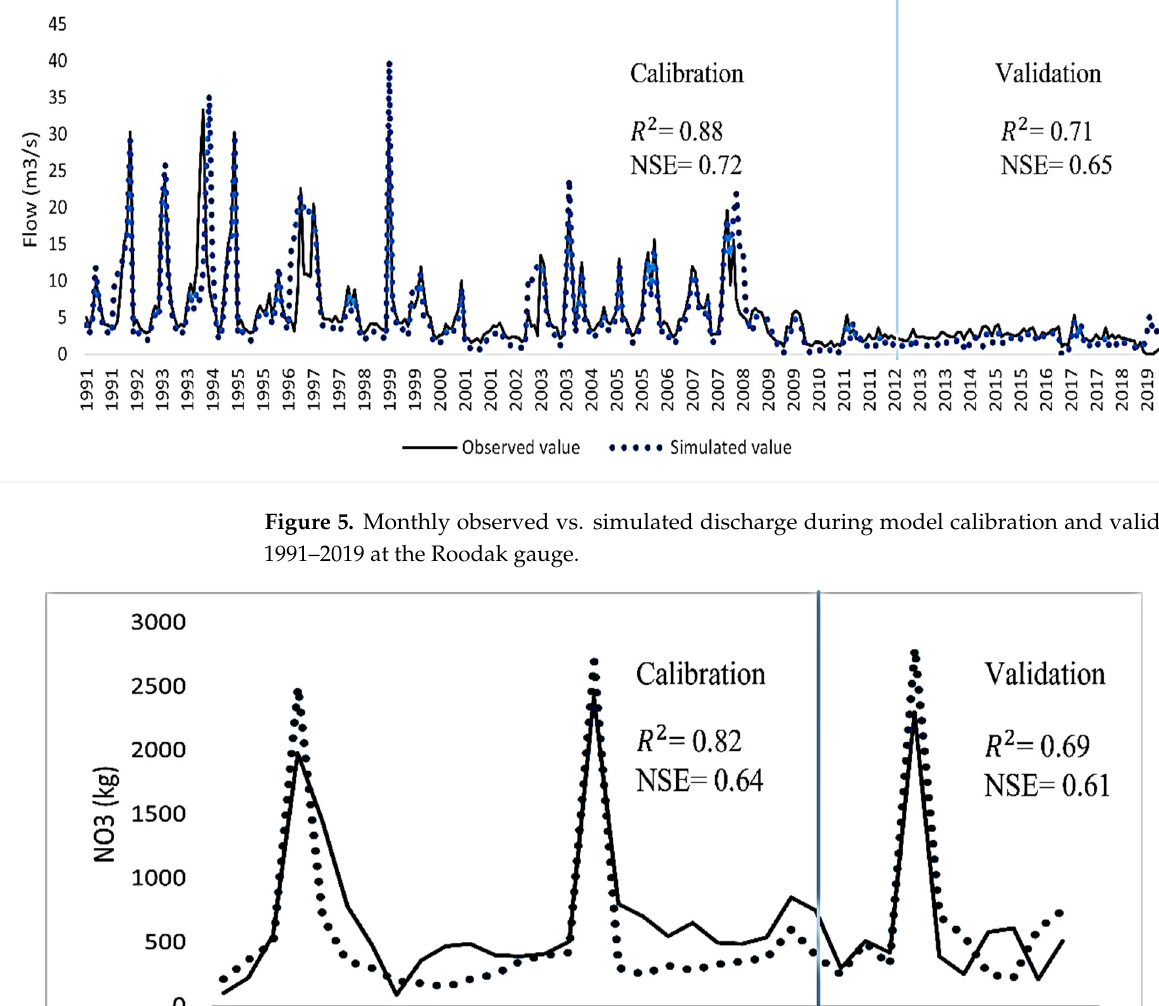
Table 4. Calibration and validation results of all seven stations for streamflow.